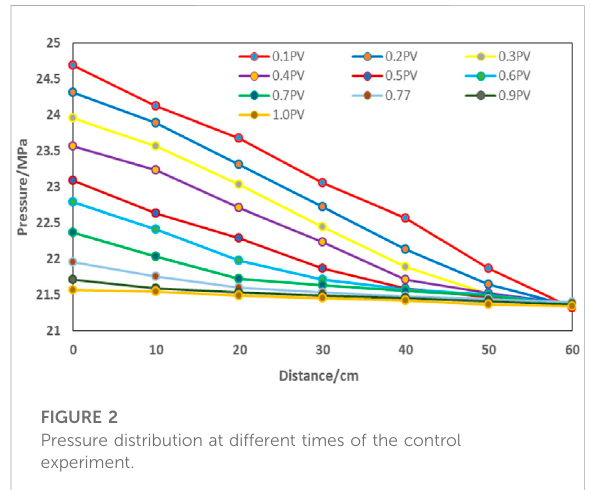
FIGURE 2 Pressure distribution at different times of the control experiment.